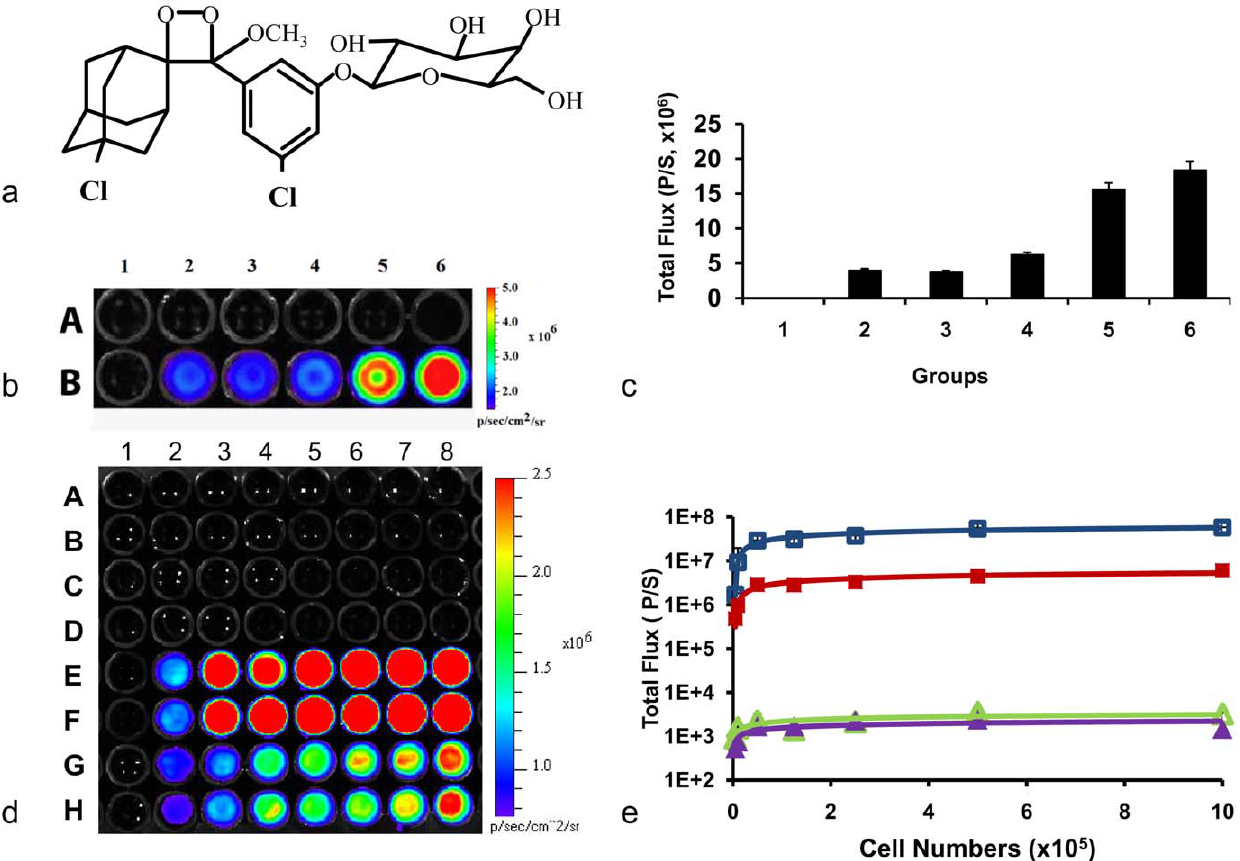
Figure 1. Detection of b -gal activity by chemiluminescent imaging (CLI) using b -gal enzyme and cultured cells. a ) The chemical structure of Galacto-Light PlusTM substrate; b ) Differential light emission from wells containing various enzyme + substrate mixtures. Row A: 10 m l PBS; Row B: b -galactosidase (1 U in 10 m l PBS (pH: 7.2-7.4)); 1 : + 20 m l PBS; 2 : + 1 m l Galacto-plus (diluted to 10 m l in PBS) + 10 m l PBS; 3 : + 10 m l reaction buffer) + 10 m l PBS, 4 : + 10 m l accelerator buffer + 10 m l PBS; 5 : + 1 m l Galacto-plus + 10 m l reaction buffer + 10 m l accelerator buffer (1:10:10); 6 : + 2 m l Galacto-plus + 8 m l reaction buffer + 10 m l accelerator buffer (1:4:5) (Total volume: 30 m l per well). c ) CLI signal intensity for mixtures in (b) d ) Varying numbers of MCF7- WT (upper A&B) and MCF7 -lacZ (lower C&D) breast cancer cells in wells (0, 1 6 10 3 , 5 6 10 3 ,1 6 10 4 , 5 6 10 4 , 1 6 10 5 , 5 6 10 5 , 1 6 10 6 cells, respectively) imaged using a sensitive CCD camera (exposure time 2 s) following addition of Galacto-Light PlusTM mixture (comprising 10 m l substrate + 10 m l accelerant + buffer with (rows A,B E, F) or without (rows C, D, G, H) added lysis buffer); e ) Signal intensities for MCF7- lacZ ( & ) and - WT ( D ) cells in (d), where open symbols indicate inclusion of lysis buffer. Exposure times ranged from 5 s to 120 s to ensure adequate SNR without